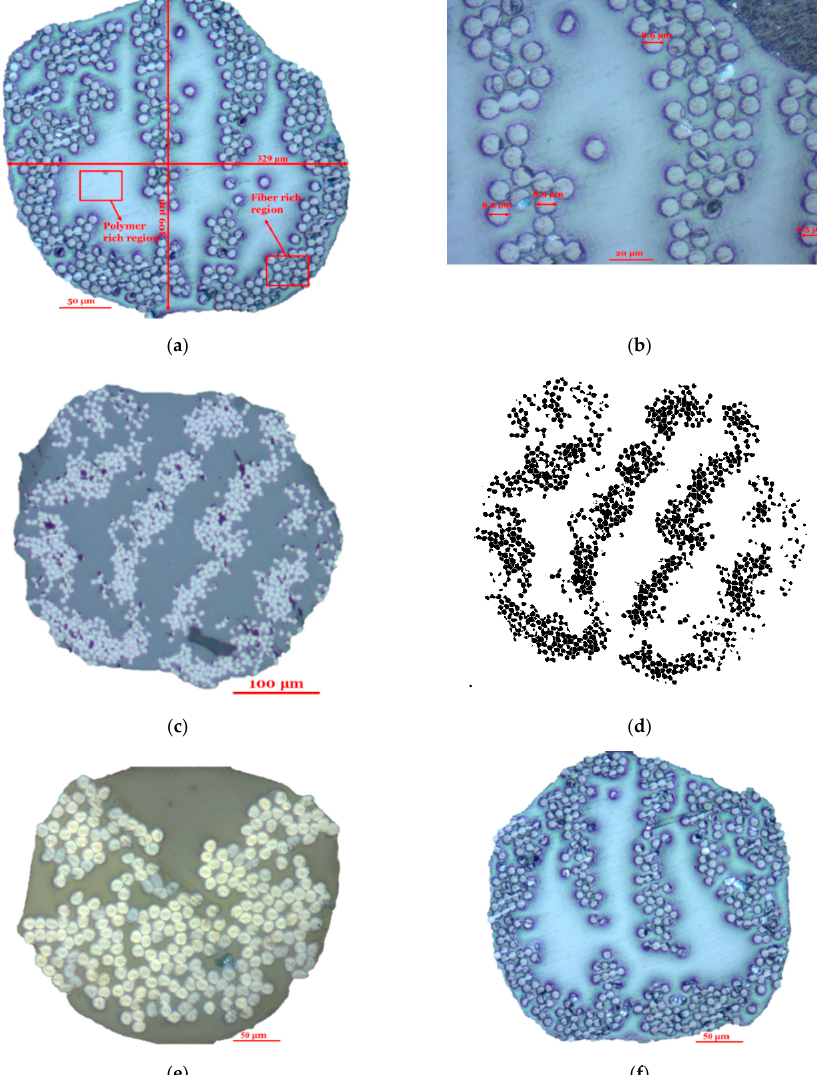
Figure 4. Cross-sectional views of fiber filaments (for fiber supply); fiberglass at 200× ( a ), fiberglass 500× ( b ), carbon fiber at 100× ( c ), carbon fiber filament tows shown as dots applying cell counting procedure using ImageJ ( d ), Kevlar at 200× ( e ) and high strength high temperature fiberglass (HSHT) FG at 200× ( f ).